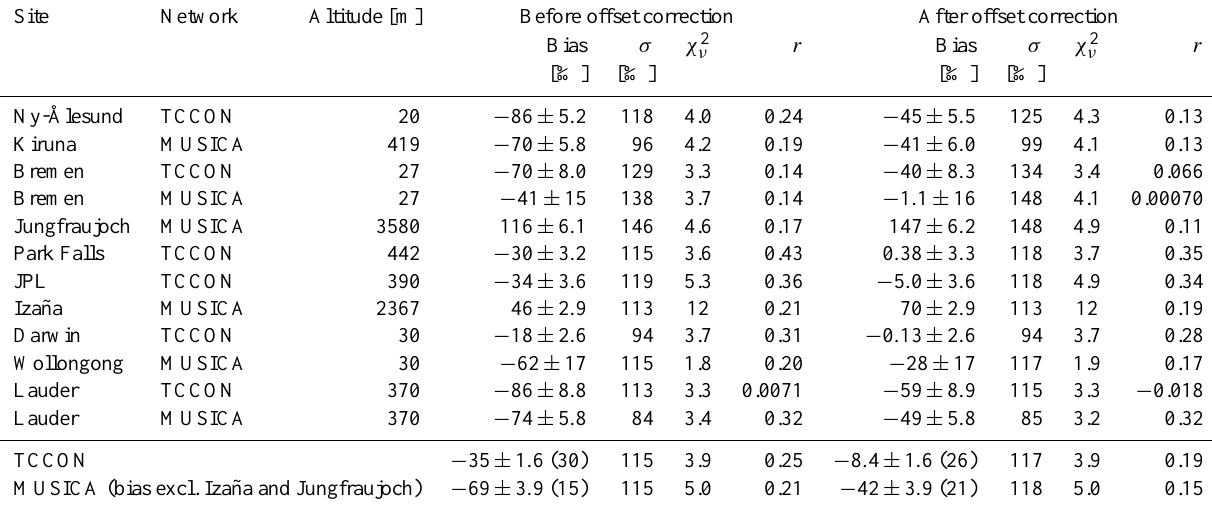
Table 2. Results of the SCIAMACHY-FTS comparisons before and after the SCIAMACHY offset correction. The last two rows show the weighted mean of the bias (including error in the mean) for all six TCCON stations and the four low-altitude MUSICA stations. The values within brackets are the station-to-station standard deviation. The other values in the last two rows are unweighted averages for all six TCCON and MUSICA